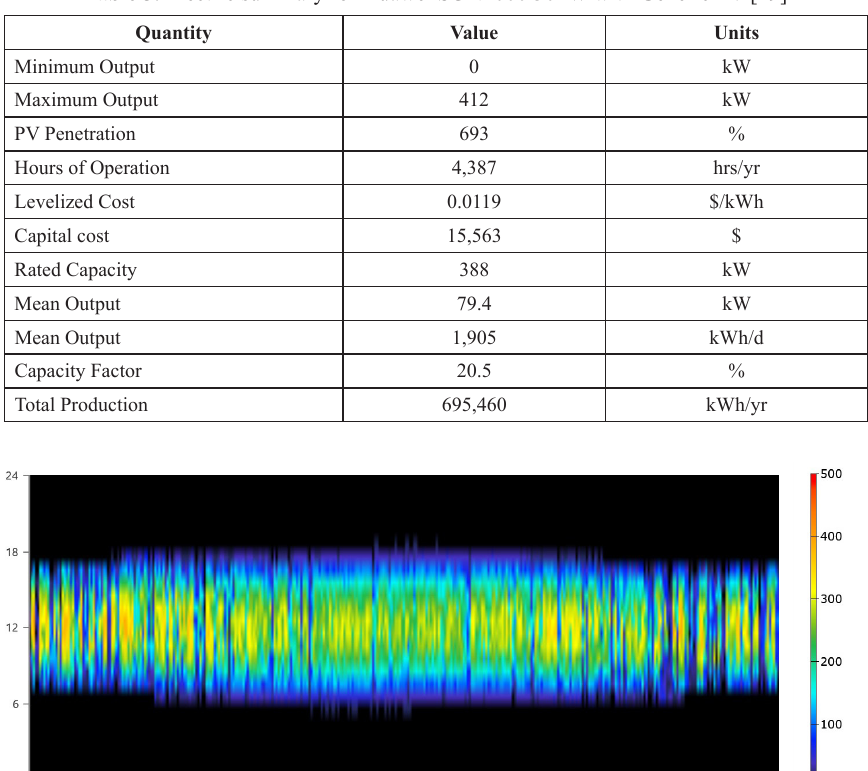
Table 3. Electric summary for Huawei SUN2000 30kW with Generic PV [19]